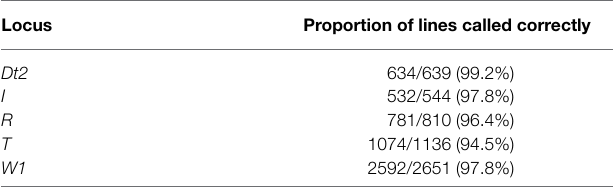
TABLE 2 | Rates of concordance between marker-based allele calls using flanking markers and the observed phenotype for five loci in the SoyNAM population.